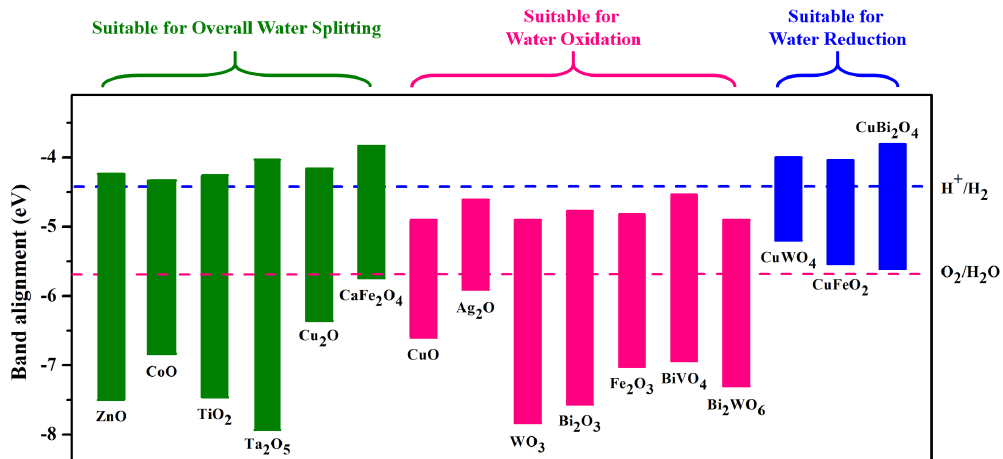
Figure 6. Band alignments of some typical 2D metal-composite oxides with respect to the water reduction and oxidation potential for photocatalytic water splitting. The band alignments data are from references